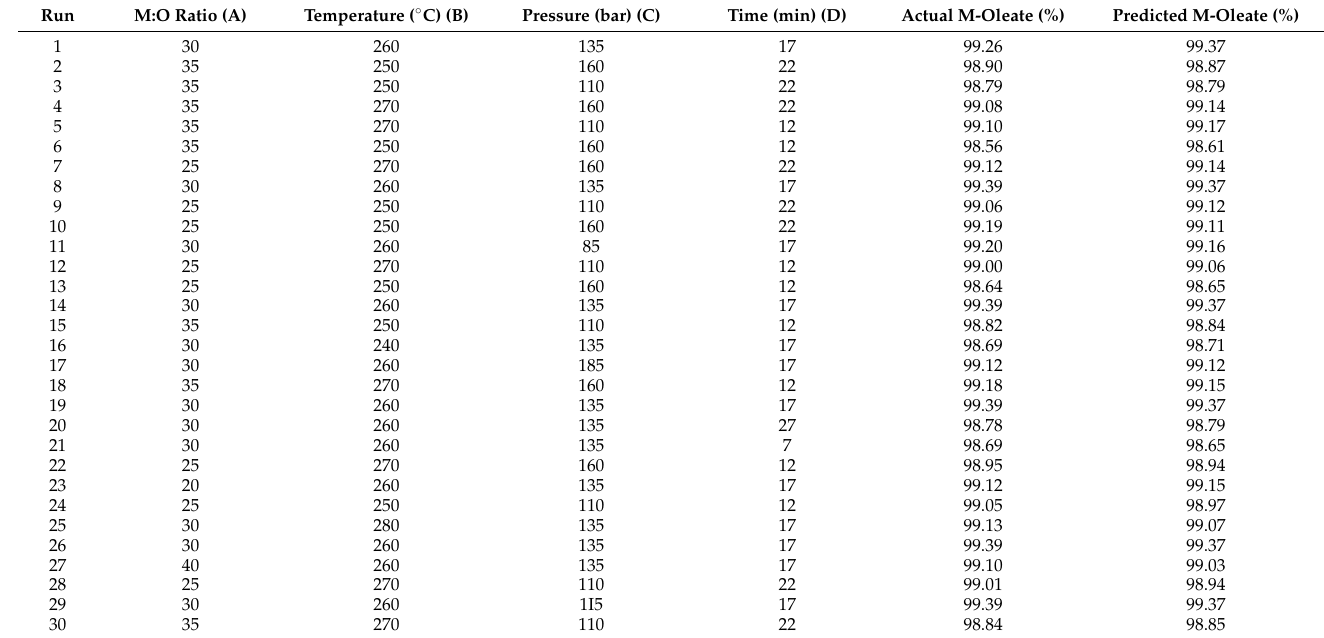
Table 4. Experimental design variables and their coded levels of methyl oleate